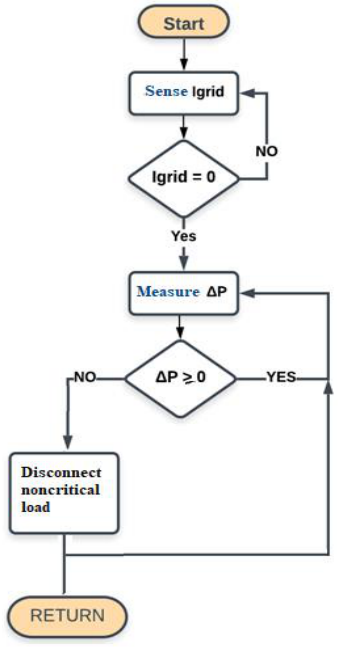
Figure 4. Load shedding flowchart.